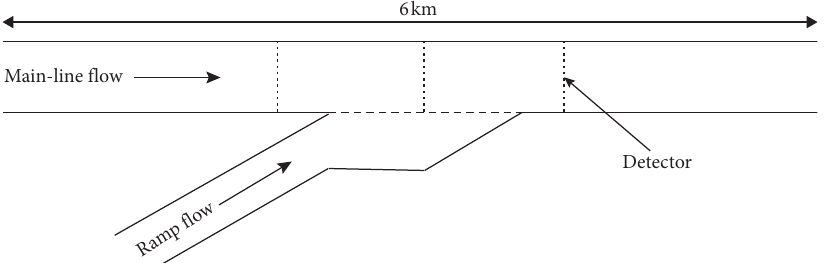
Figure 9: Geometric characteristics of the simulation road and VTG policy, respectively. It can be clearly seen that In Figure 10, the blue curve represents the theoretical there are deviations between the simulation data and the curves with 0% penetration rates, and the red curve analytical results. This largely results from the fact that the represents the theoretical curves with the given pene- field traffic flow is difficult to reach and maintain at a tration rates. The black points and red points are the stable state. However, the corresponding throughput in density-volume data of the simulation results with CTG